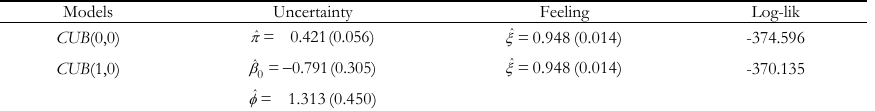
Estimation of CUB models for Black color